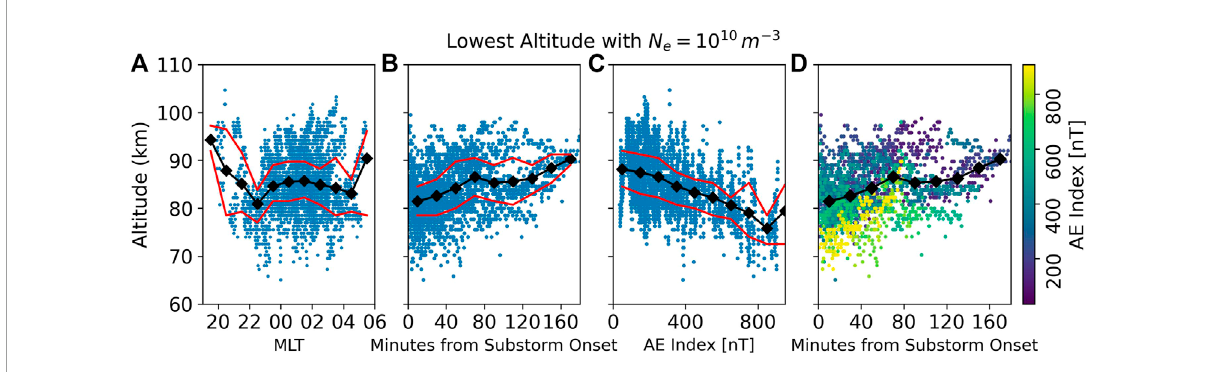
FIGURE 2 Lowest altitude PFISR measurements during pulsating aurora with N e = 10 10 m −3 plotted versus magnetic local time (A) , time from the nearest substorm onset (B) , AE index (C) , and combined substorm and AE (D) . The black diamonds indicate the average altitude for the surrounding hour, 20 min, 200 nT of AE, and 20 min respectively. The red lines indicate the 25% and 75%